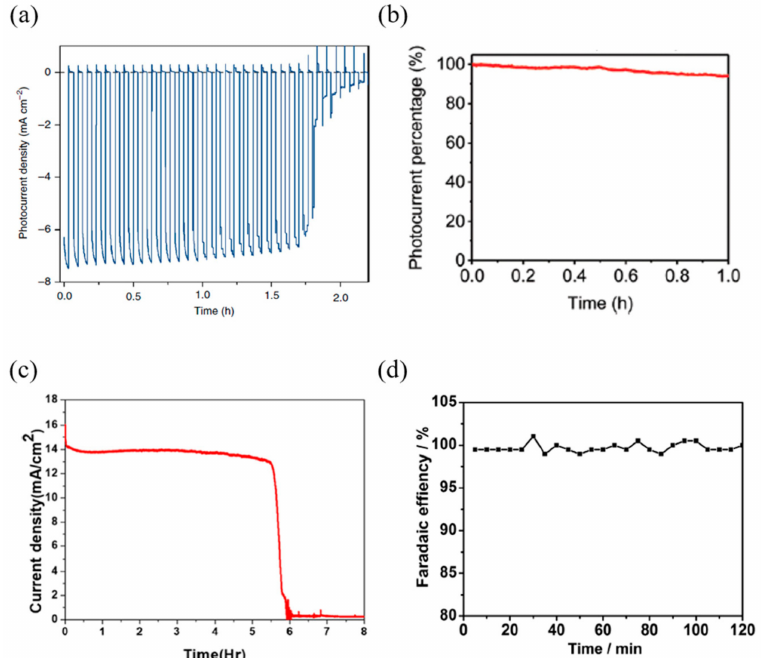
Figure 10. Cases of improving stability by passivation. ( a ) Chronoamperometric trace recorded at an applied potential of 0 V vs. RHE. An aqueous bu ff er solution (0.1 M borate, pH 8.5), chopped solar light irradiation (AM 1.5 G, 100 mW / cm 2 , λ > 400 nm). ( b ) Stability analysis at 0 V RHE . ( c ) Current vs. time graph of perovskite photoanode under illumination (0.7 sun) and bias (1.3 V vs. RHE) in KOH solution (pH 14). ( d ) Faradaic e ffi ciency for hydrogen evolution on the Pt–Ti / CH 3 NH 3 PbI 3 photocathode with Pt and SCE as the counter and reference electrodes, respectively, in 0.5 M H 2 SO 4 solution